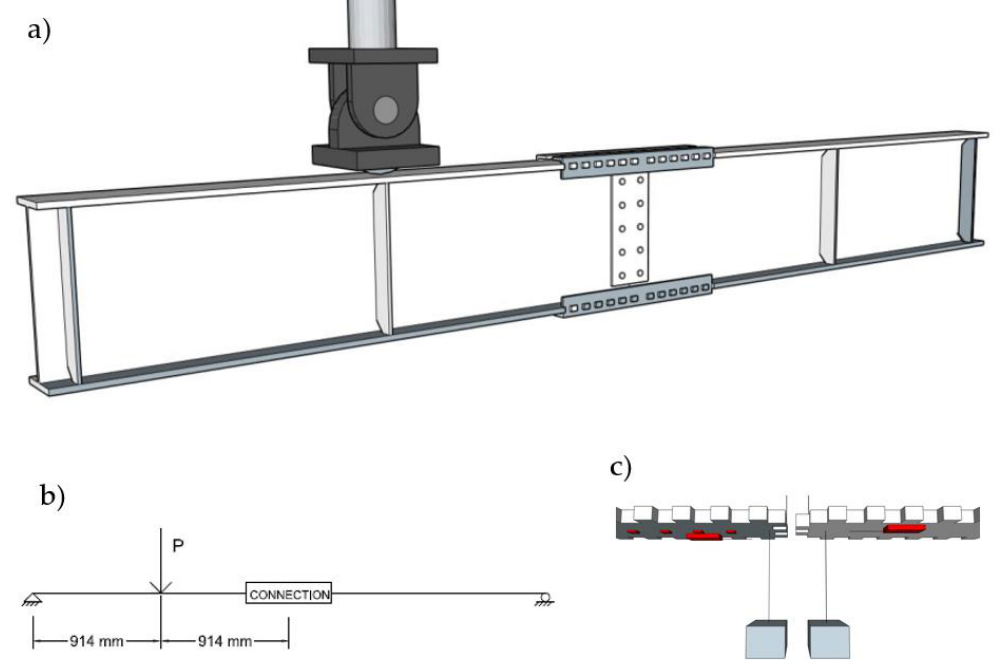
Figure 9. Beam test-2: ( a ) general arrangement; ( b ) loading diagram, ( c ) string potentiometers.